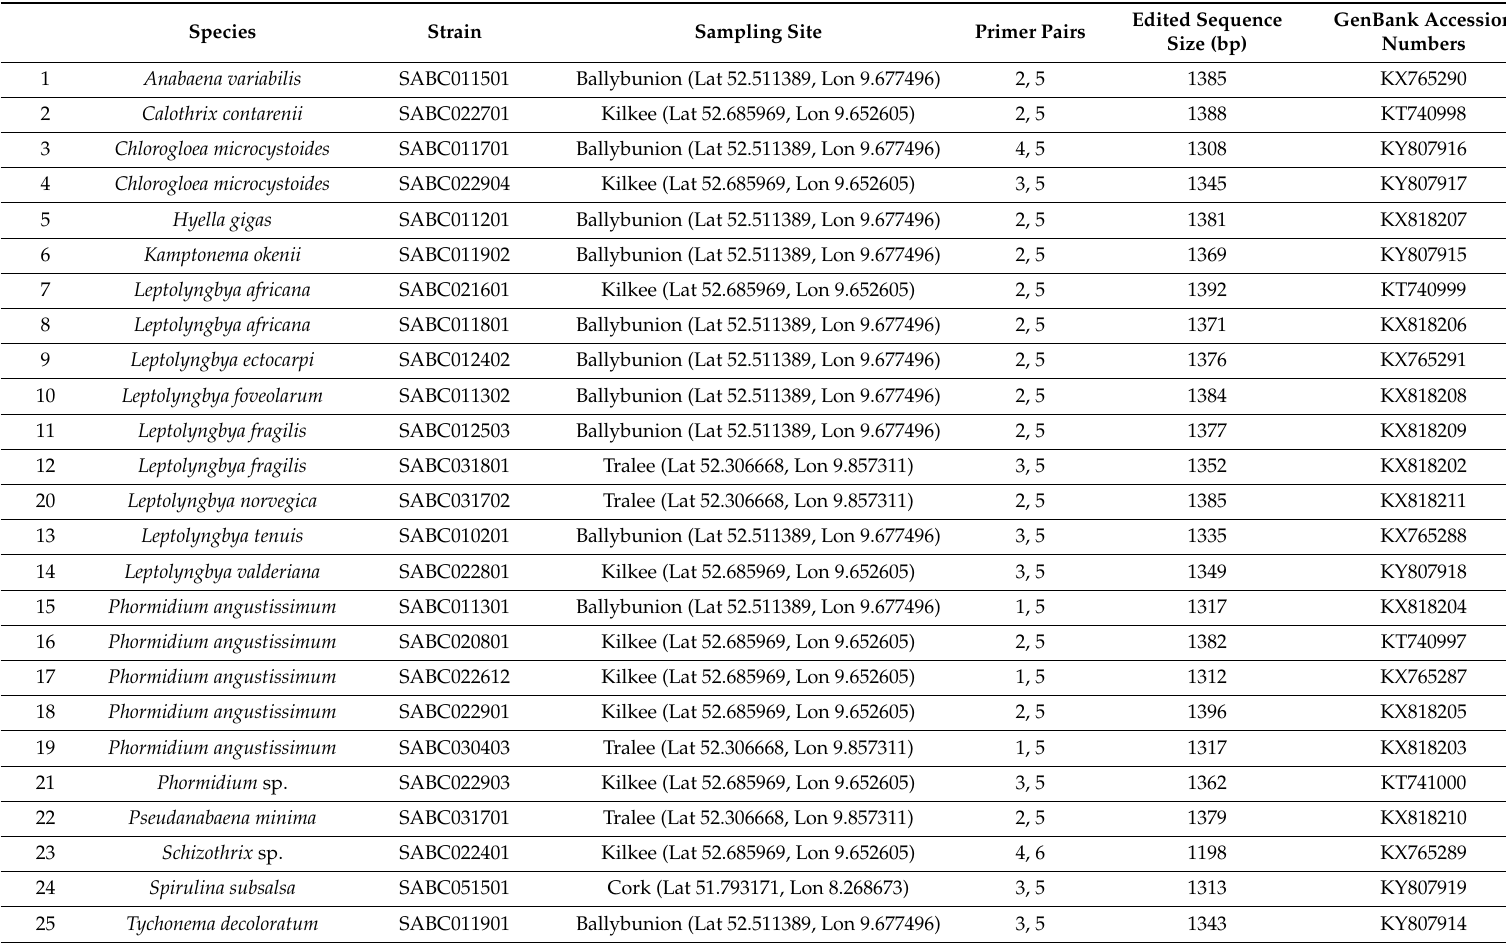
Table 2. List of Irish marine cyanobacterial strains of this study, their sampling sites, primer pairs used for amplification of 16S rRNA gene sequences, edited sequence size, and GenBank accession